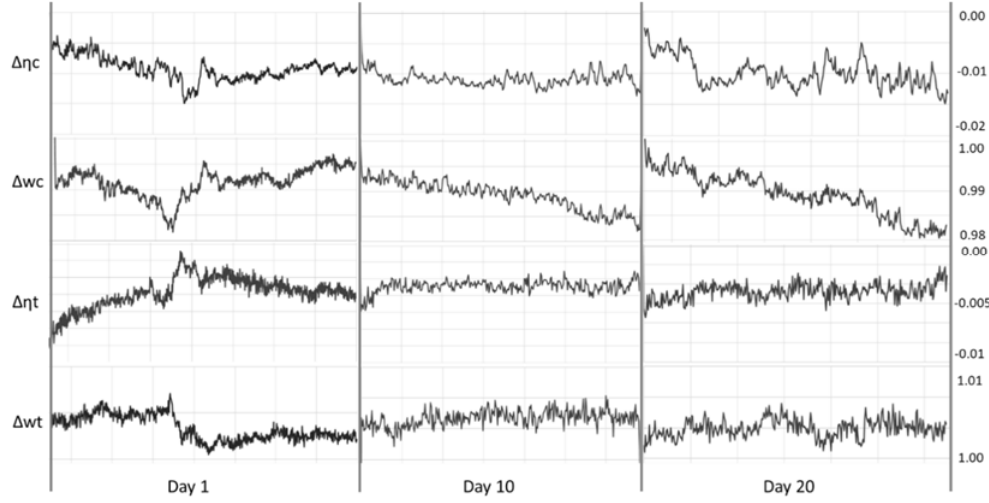
Figure 8. Estimated compressor efficiency ( ∆ η c ), compressor flow capacity ( ∆ w c ), turbine efficiency ( ∆ η t ), and turbine flow capacity ( ∆ w t ) deviations in the first 20 days of Scenario 2.